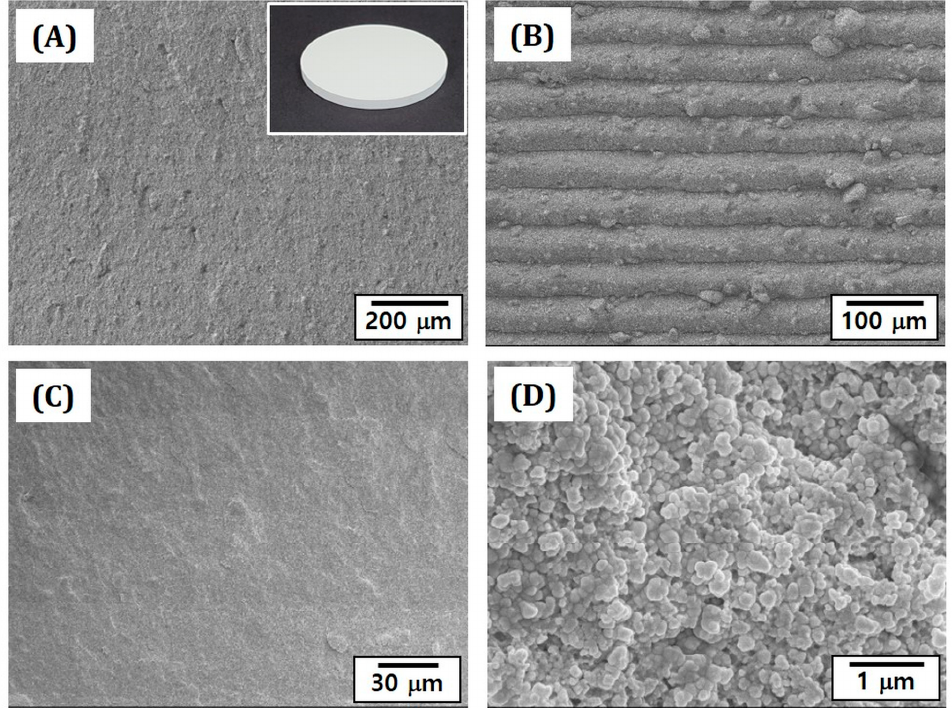
Figure 8. Representative FE-SEM images showing free surfaces ( A , B ) and fracture surfaces ( C , D ) of as-manufactured 4Y-PSZ disk in the building direction. The inset in Figure 8 ( A ) shows representative optical image of the as-manufactured 4Y-PSZ disk (diameter = 14.4 mm).